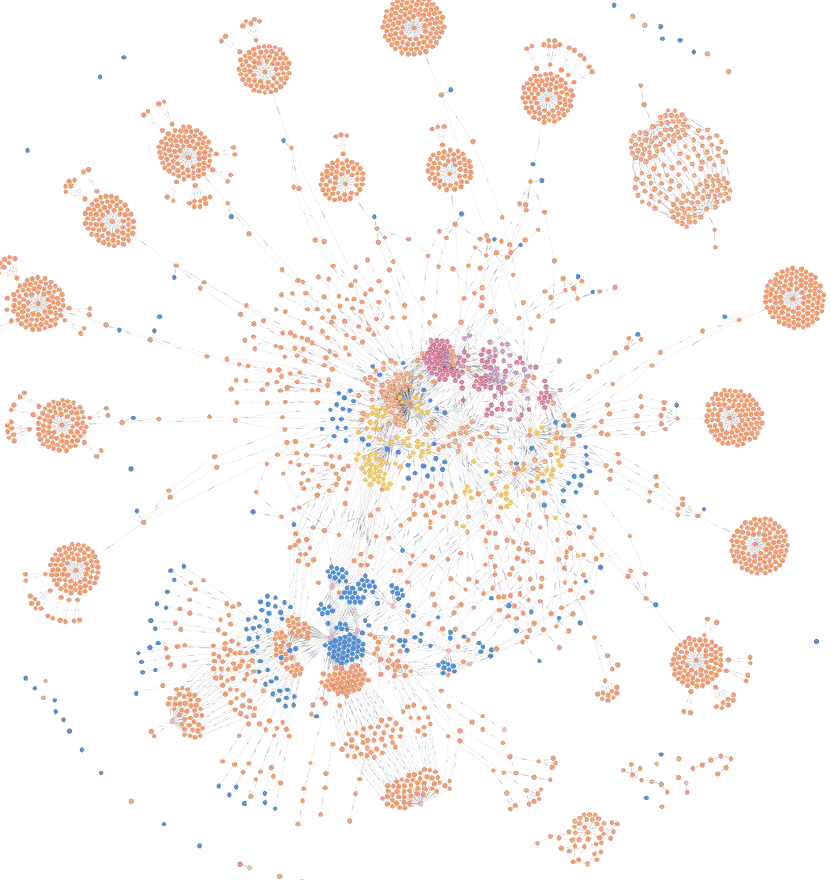
Figure 10. Graph database-based information model.